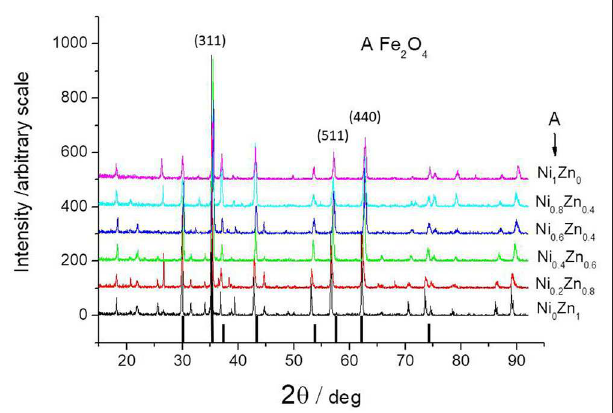
FIGURE 3 | XRD pattern of all ferrites obtained by co-precipitation method and followed by annealing at 600 ◦ C. The figure includes the standard XRD pattern for nickel ferrite (ICDD file No. 44-1485).